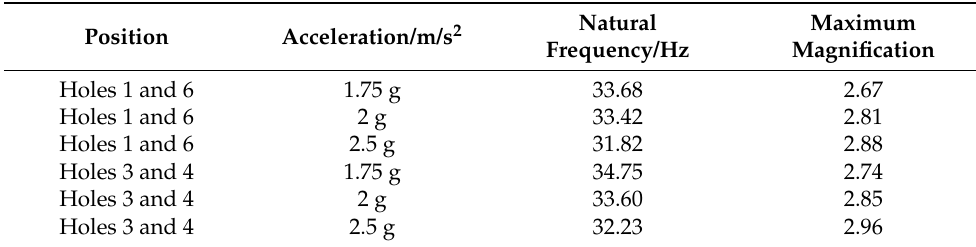
Table 4. Experimental results of the dynamic frequency sweep of vibration isolators with differ- ent distances.